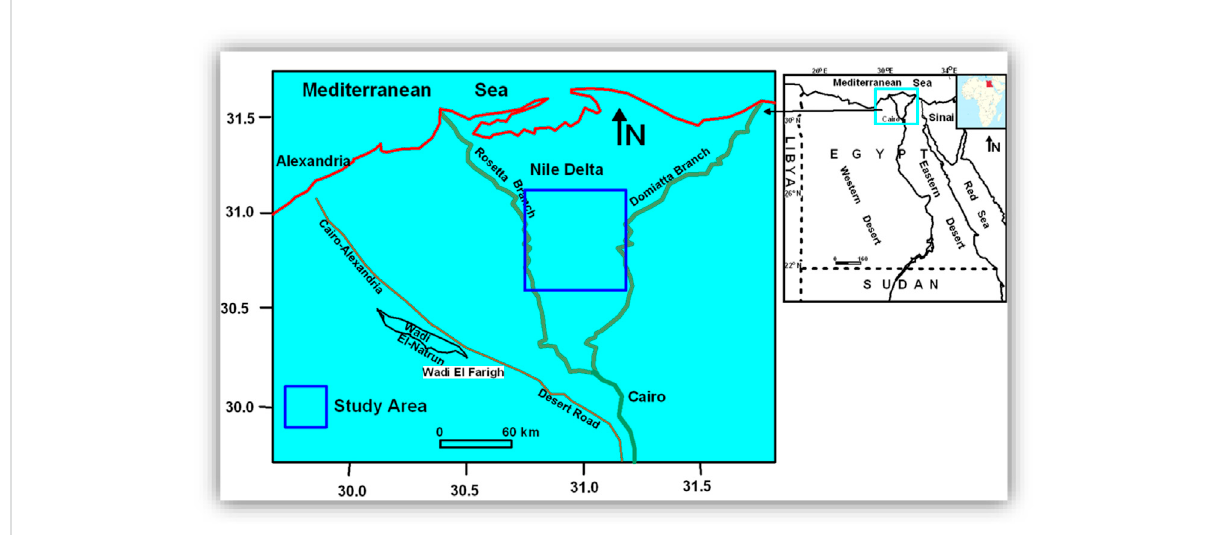
FIGURE 1 Maps show the geographic location of the study area.